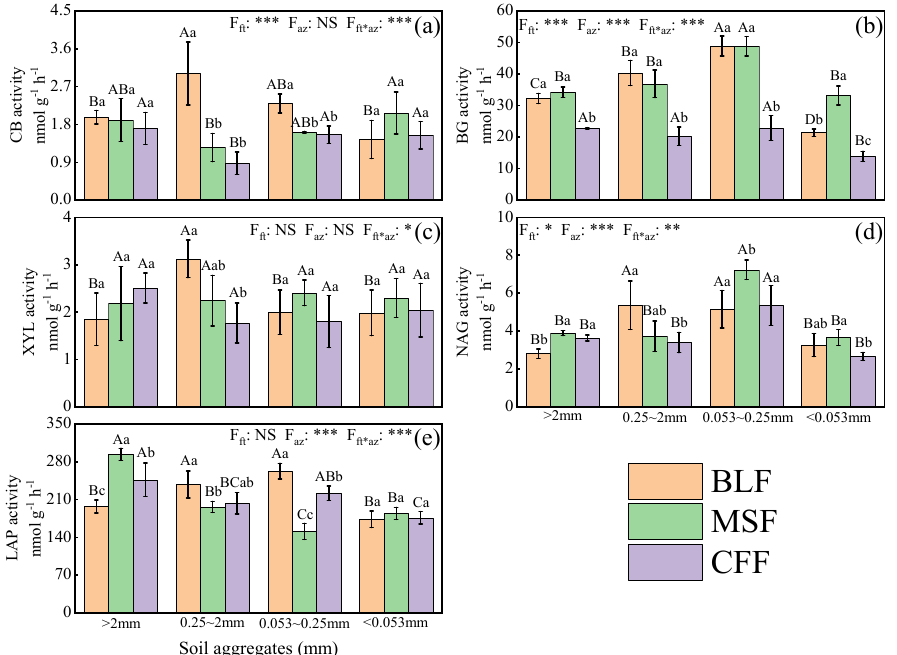
Figure 5. The comparison of soil aggregate enzymatic activities in different forest types of the same fraction and different fractions of the same forest type. CB: cellobiohydrolase ( a ), BG: β -glucosidase ( b ), XYL: β -xylosidase ( c ), NAG: N-acetylglucosaminidase ( d ),LAP ( e ): leucine aminopeptidase, respectively. Bars with different letters are significantly different ( p < 0.05). Small letters indicate difference of soil enzyme activities in three forest types with the same fraction. Large letters indicate difference of soil enzyme activities in different fractions in the same forest types. F ft represents forest type, F af represents aggregate fraction, NS indicates no significant difference, *: p < 0.05, **: p < 0.01, ***: p < 0.001.